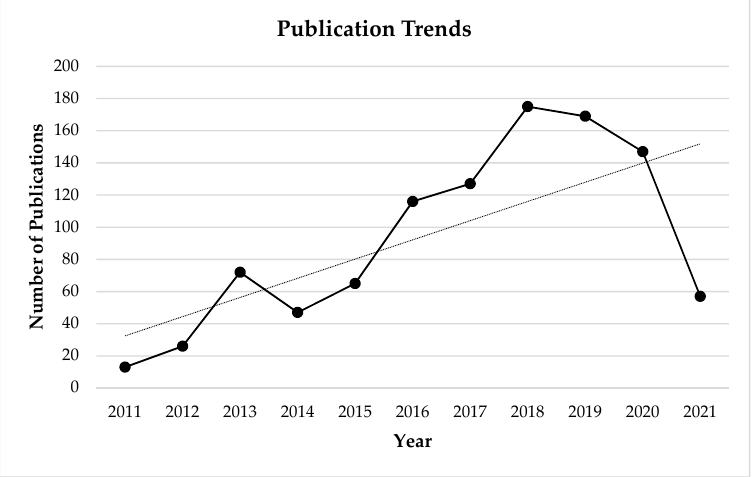
Figure 3. Google Scholar publication trends based on search term results over the past decade.